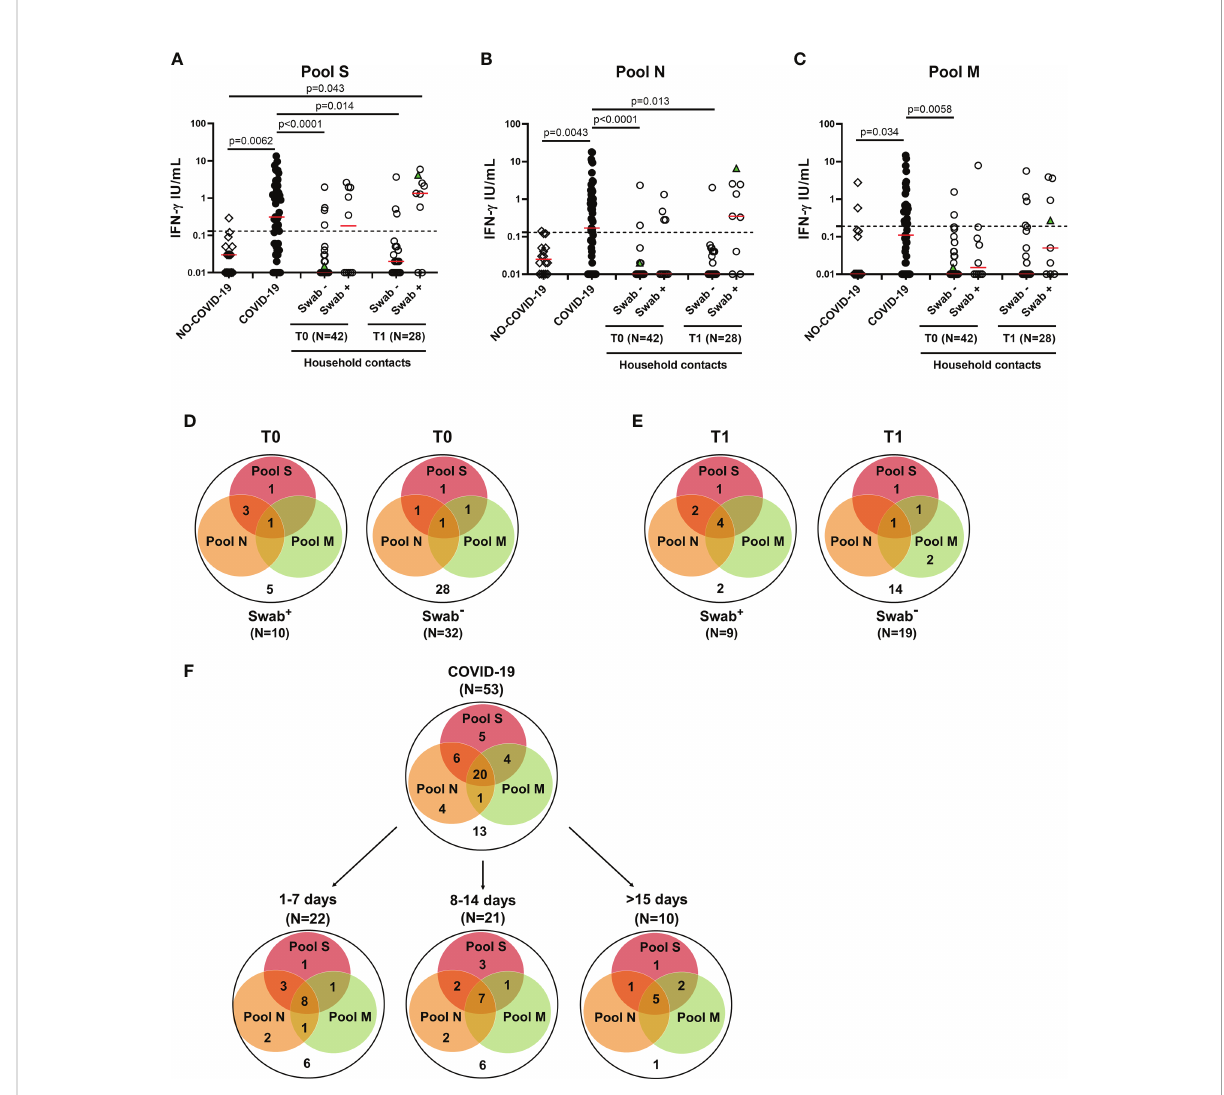
FIGURE 3 T-cell response in household contacts of COVID-19 subjects. (A-C) Evaluation of IFN- g levels in response to SARS-CoV-2 peptides in household contacts at T0 (n = 42) and T1 (n = 28) after whole-blood stimulation with 0.1 µg/mL of pools S (A) and M (C) , and 1 µg/mL of pool N (B) . Healthy donors (n=16) and COVID-19 patients (n = 53) were used as negative and positive control groups, respectively. The household contacts were strati fi ed according to the swab result. The IFN- g levels were assessed in plasma from stimulated whole-blood samples and reported by subtracting the background. The cut-off for each peptide pool was represented by a dashed line (pools S and N: 0.13 IU/mL; pool M: 0.19 IU/mL). Green triangle indicates the subject who scored positive only at T1. The red horizontal lines indicate the median. (D, E) Venn diagrams show the number of household contacts of COVID-19 cases at T0 and T1 with a positive response to the different SARS-CoV-2 peptides pools. (F) Venn diagrams show the number of con fi rmed hospitalized COVID-19 patients with a positive response to the different SARS-CoV-2 peptides pools, stratifying the results also with respect to days from symptom onset. The statistical comparison was done with the Kruskal-Wallis test and the Dunn ’ s multiple comparisons test, and p<0.05 was considered signi fi cant. IFN, interferon; COVID-19, COronaVIrus Disease 2019; S, spike; N, nucleocapsid; M,